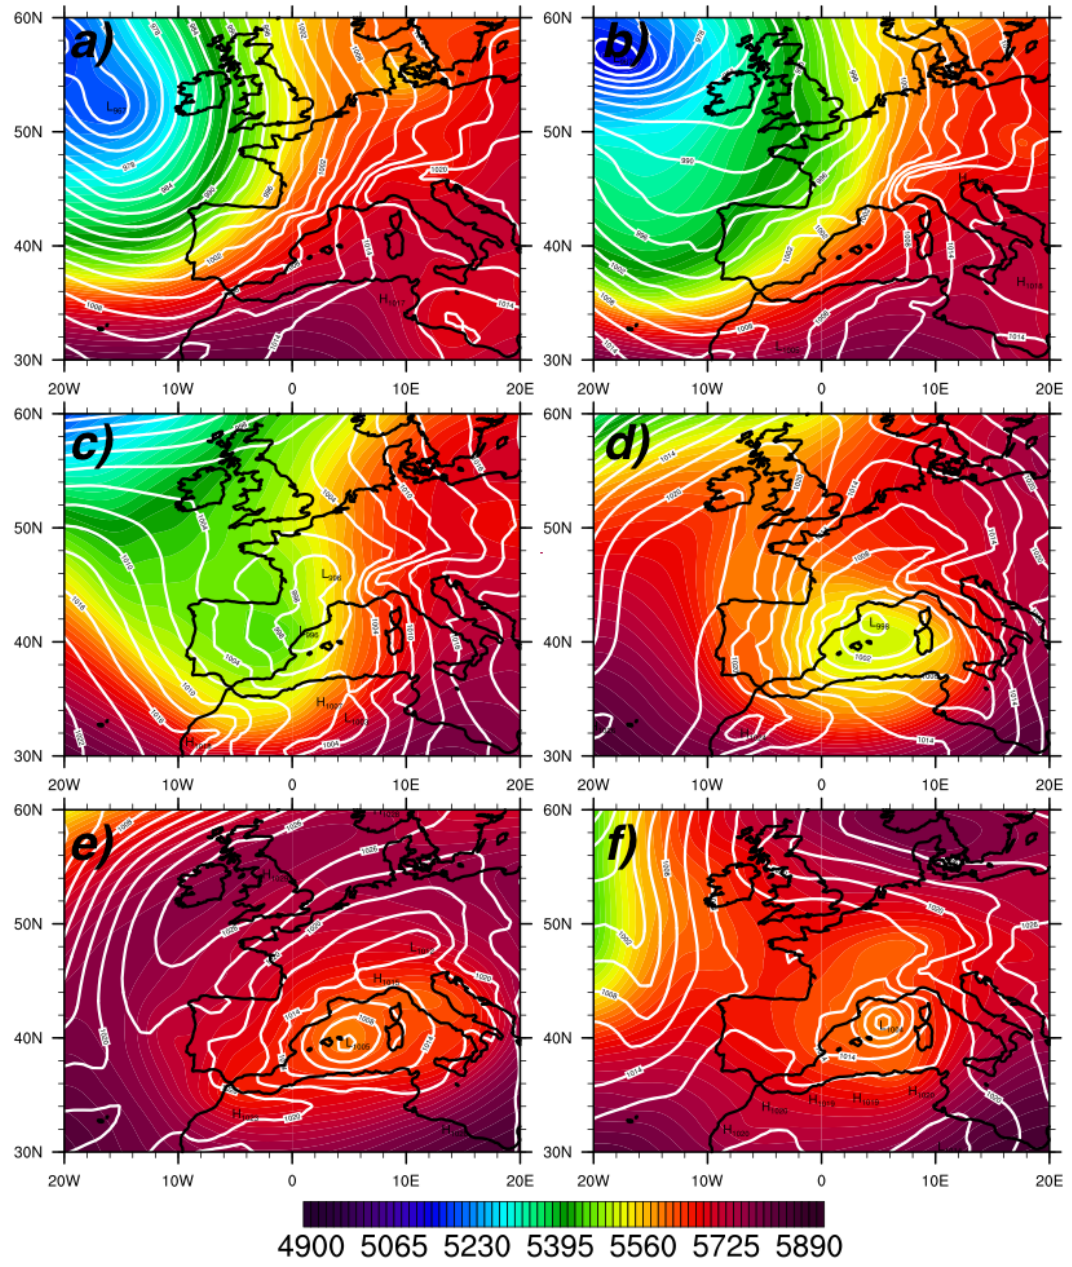
Figure 1. Snapshots of surface pressure (white lines; c.i. = 3 hPa), and 500 hPa geopotential height (colors) on 3 November 2011, 00 UTC (panel ( a )) and 4 November 2011, 00 UTC (panel ( b ))—during the transit of the Atlantic baroclinic wave over Spain, close to the Balearic Sea-, 5 November 2011, 00:00 UTC (panel ( c ))—during the formation of the ROLF depression over Spain-, on 6 November 2011, 00:00 UTC (panel ( d ))—during the cut-off low over the Balearic sea-, on 7 November 2011, 00:00 UTC (panel ( e )) and 8 November 2011, 00:00 UTC (panel ( f )). Data are from ECMWF ERA-40 (European Center for Medium range Weather Forecasting).